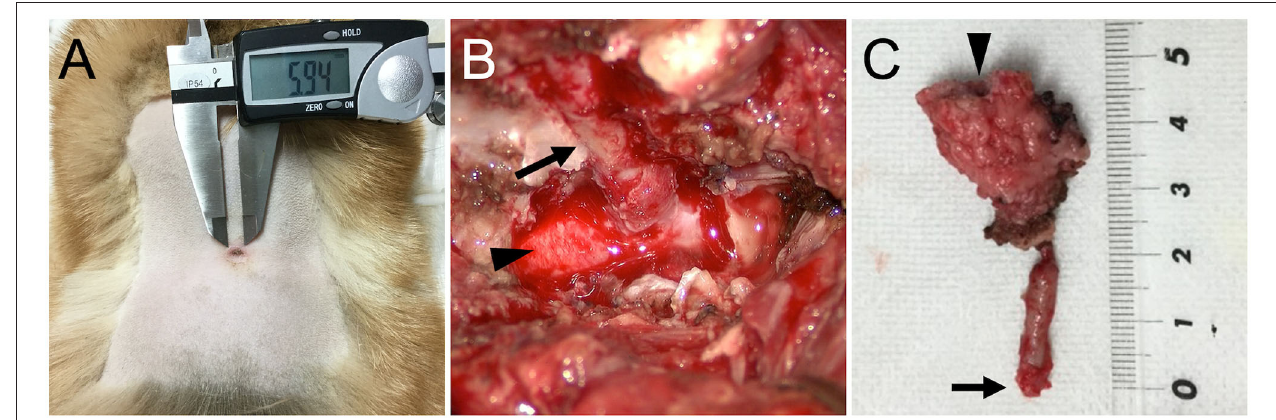
FIGURE 3 | (A) Pre-operative photograph of a fistula on the dorsum. (B) Intraoperative photograph of the dermoid sinus tract (arrow) that was passing through the hollow of the conjoint spinous processes of T1–T5. The tract was composed of firm connective tissue and continuous to the dura matter of the spinal cord (arrowhead). (C) A photograph of the surgically excised dermoid sinus. A fistula on the surface of the skin (arrowhead) and the end of the sinus tract (arrow) are